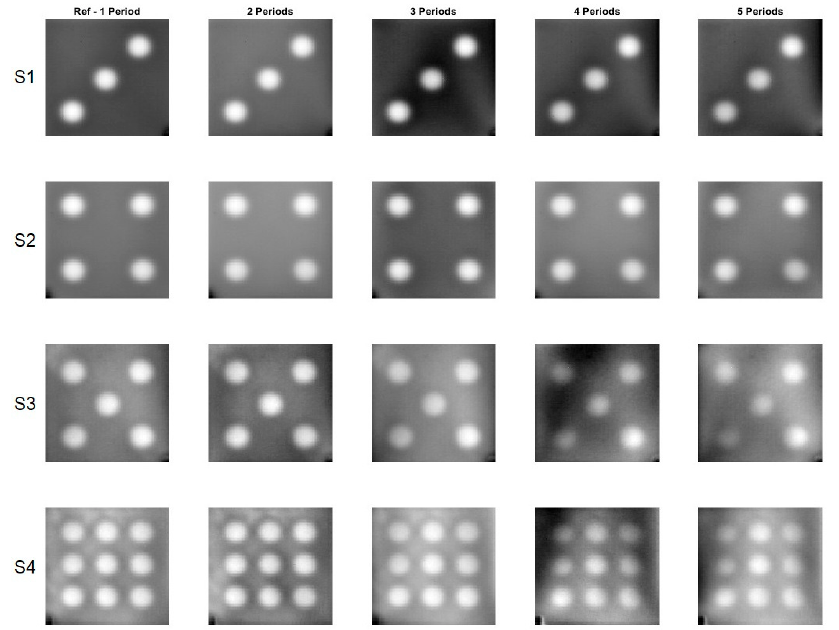
Figure 9. Phase images for the samples with the circular cross section defects. A halogen lamp was used as a source of excitation. S1–S4 denotes configuration of the circle holes.